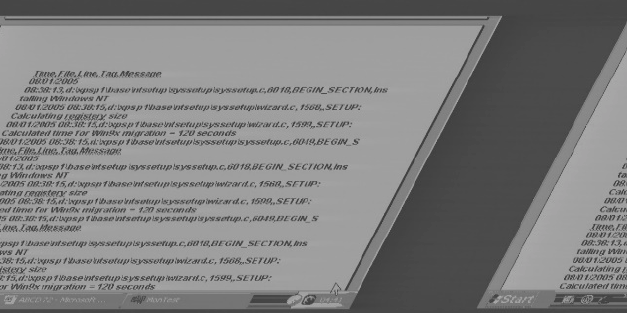
Figure 4. The reconstructed image (rasterized) in incorrect way, VGA interface signal as a source of reveal emission, 640 × 480/60 Hz mode, 62.5 MHz sampling rate, line length 1985.